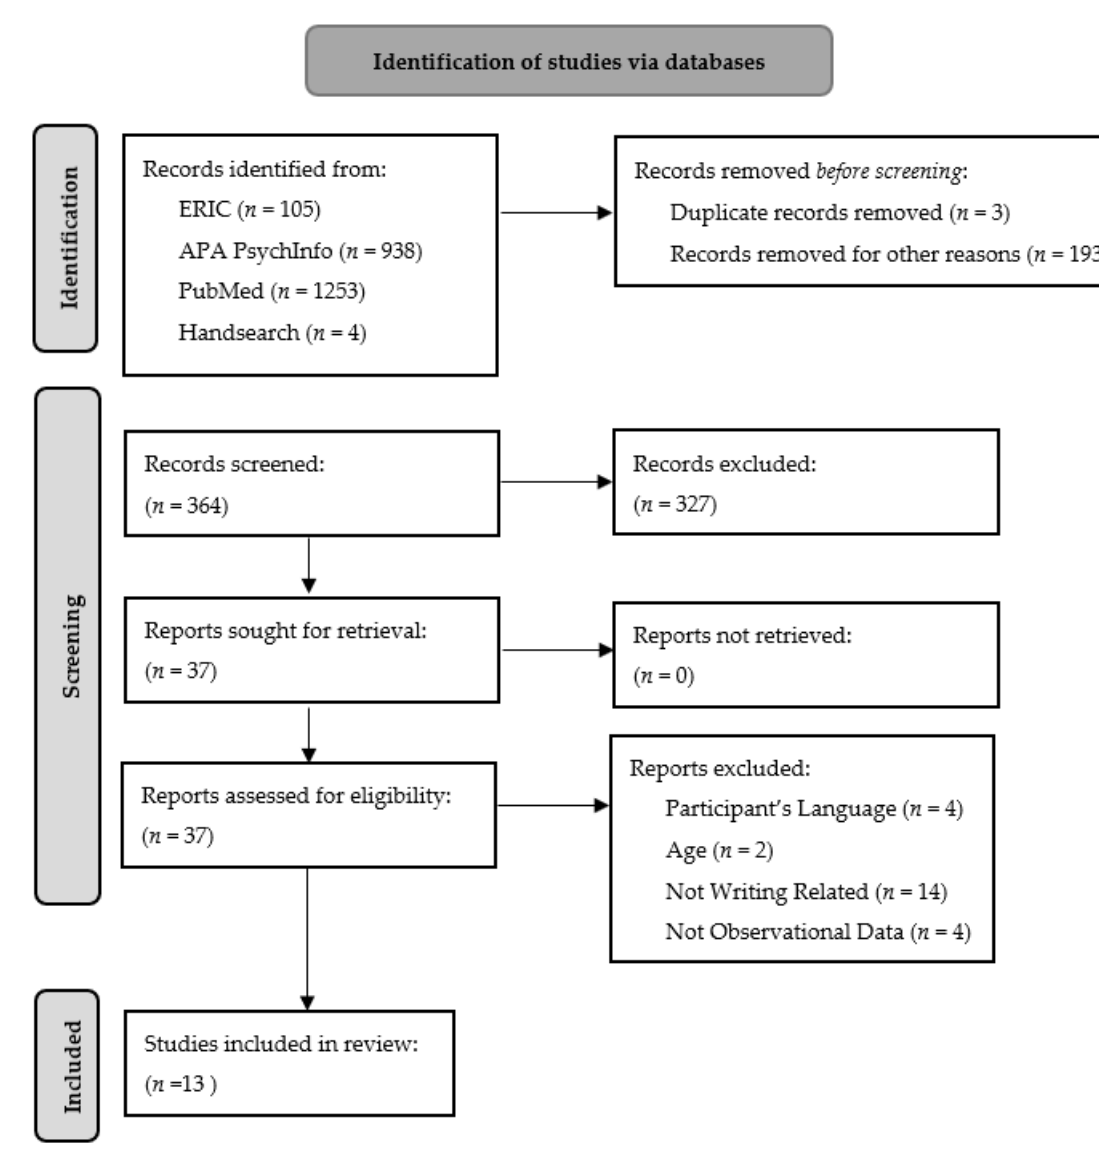
Figure 1. Scoping review flow diagram.